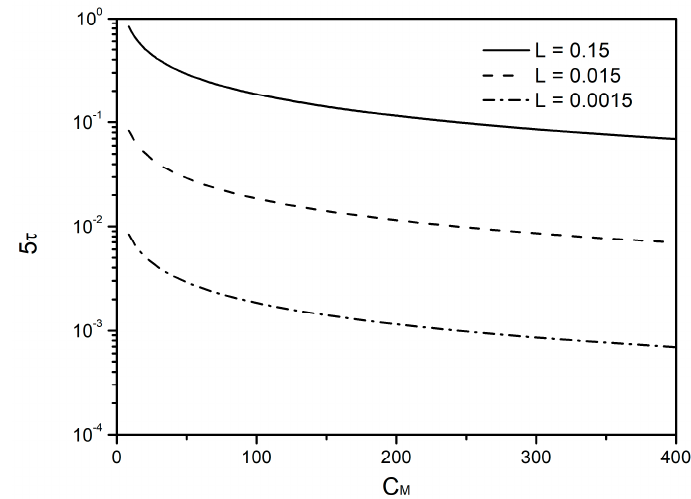
Figure 2. Time constant variation 5 τ as a function of C M for various duct widths.